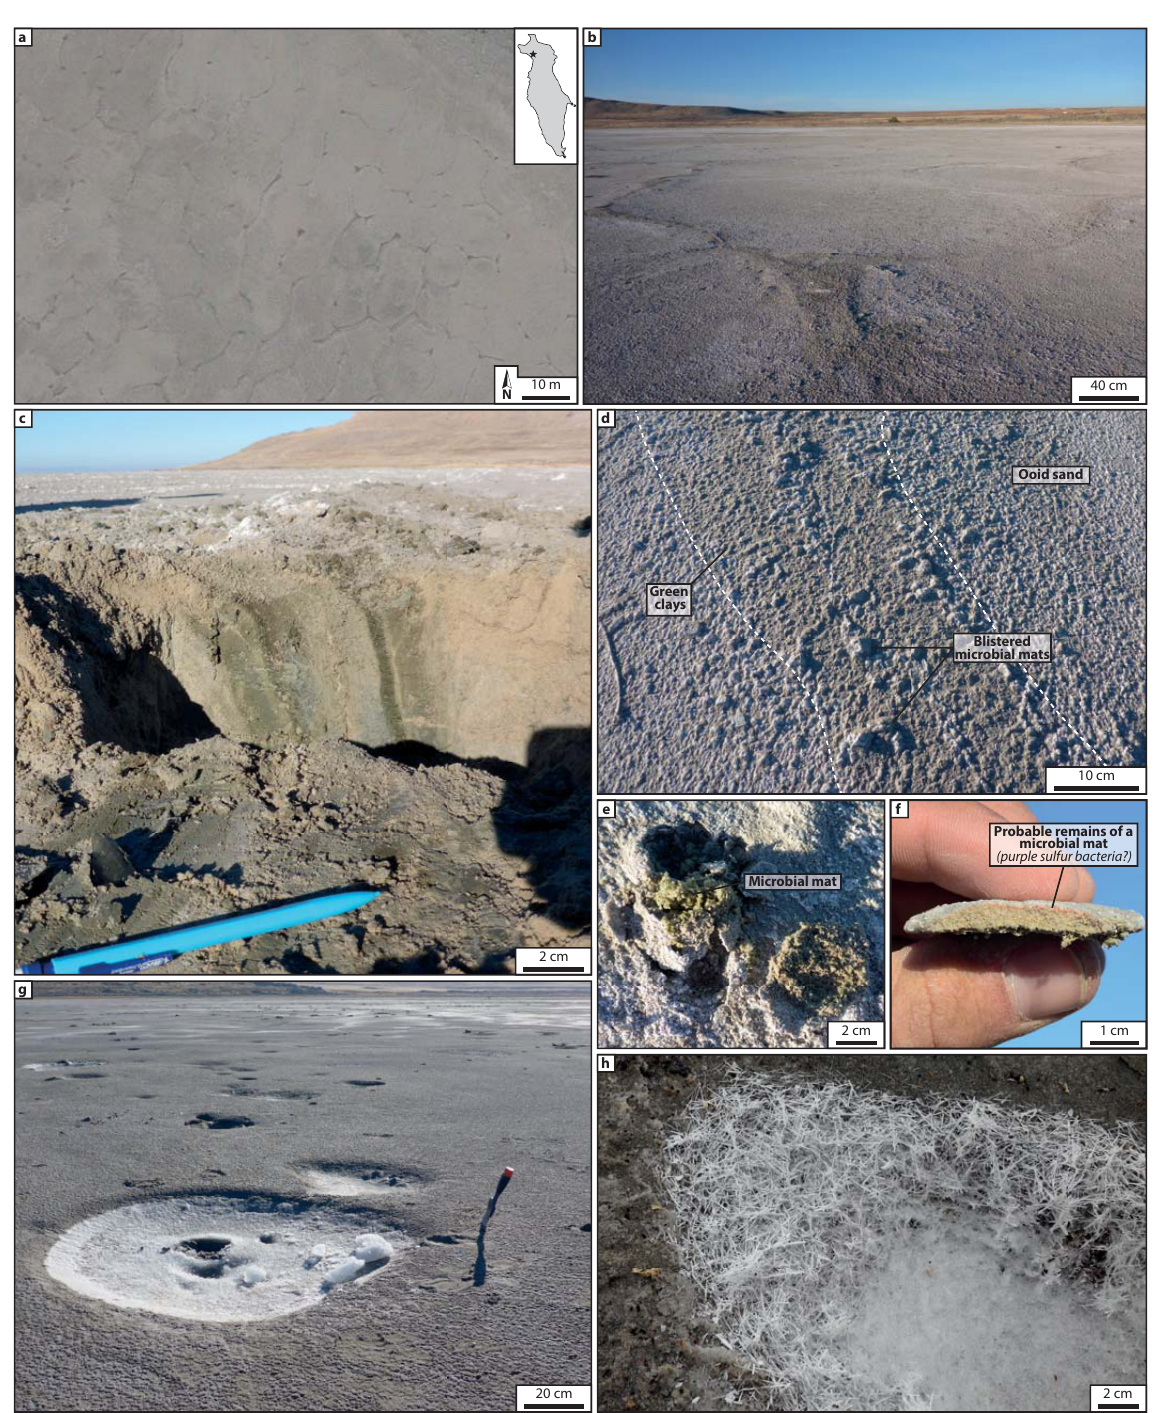
Figure 4. Polygonal architectures of the emersed White Rock Bay ooid sand flat. (a) Aerial image of the White Rock Bay polygons (Google Earth). (b) Field photograph of the emersed polygonal architecture observed in the sand flat with the rise of the underlying green clays in the cracks. (c) Section through the crack of a polygon showing the rise of the green clays. The different vertical shades of green suggest preferential fluid pathways through the clays. (d) Formation of microbial mat hemispheroids through blistering above the polygons. (e) Cut into a microbial mat hemispheroid showing green pigments, which are frequently associated with cyanobacteria. (f) Section within a hemispheroid made of cemented ooid grainstone. The presence of an infra-millimetre thin red-coloured layer 0.5mm below the top probably (cid:113) reflects the presence of purple sulfur bacteria. (g) Accumulations of mirabilite (Na 2 SO 4 10 (H 2 O)) within small depressions (sinkholes) in the vicinity of the polygons. (h) Detail of mirabilite